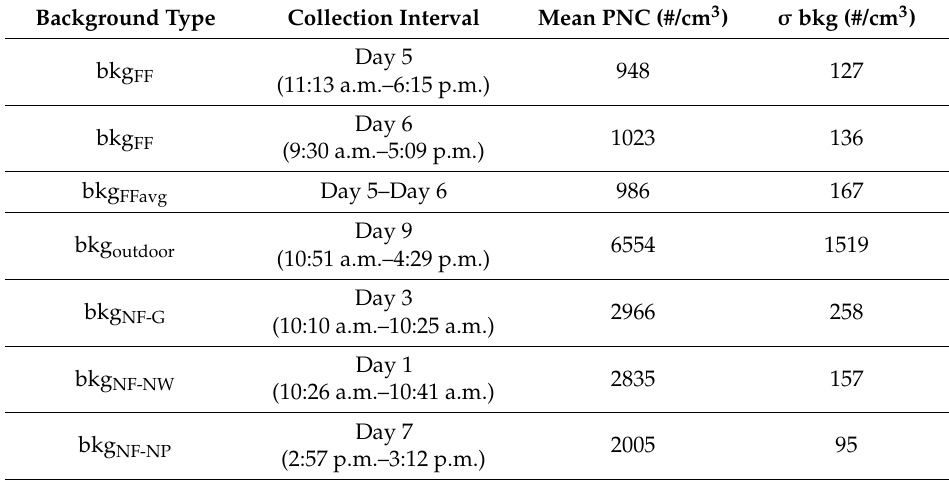
Table 1. Average and standard deviation of measured background concentrations (#/cm 3